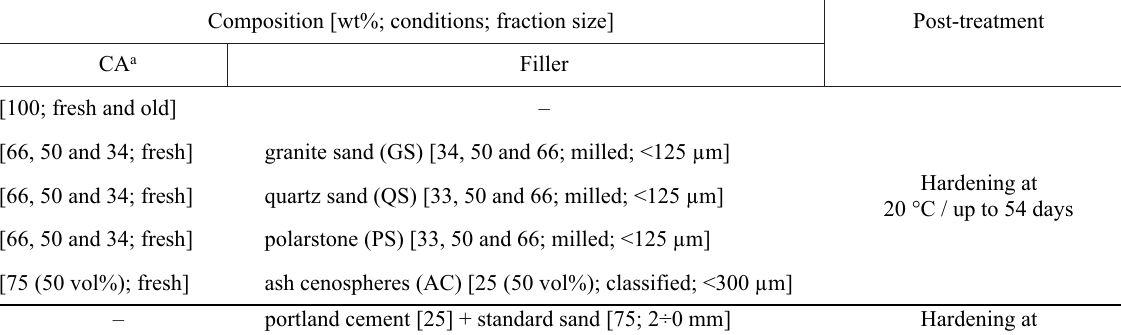
Table 1. Composition of studied materials